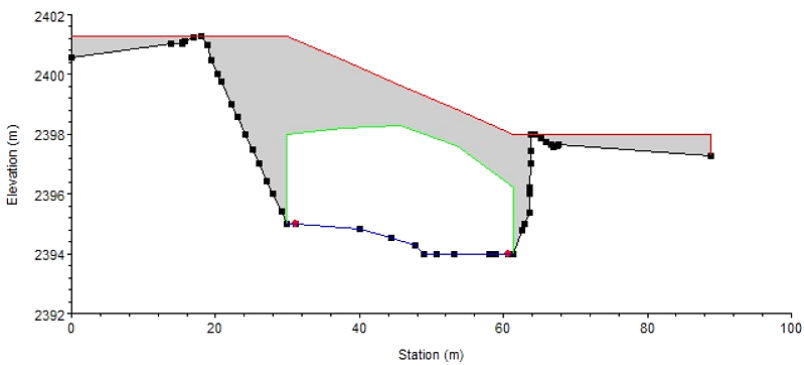
Figure 3. Riverbed models.